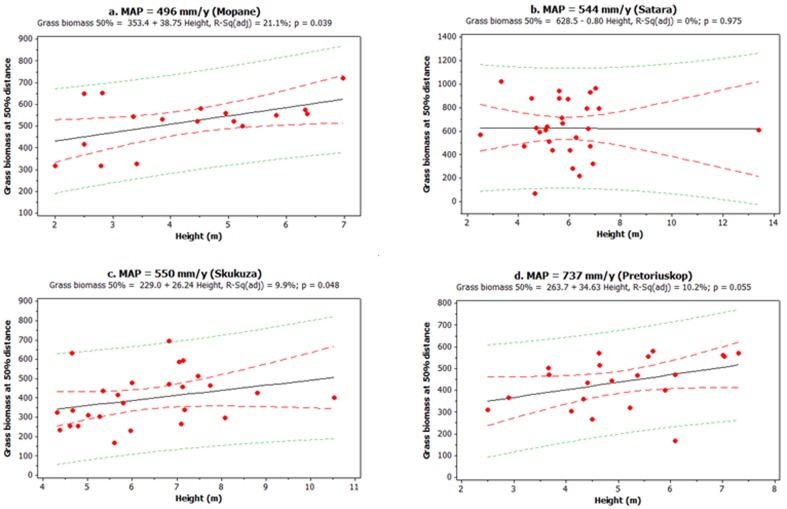
Sub-canopy grass biomass (g.m−2) as a function of tree height (m) at each of the four study sites.Sites are ordered in terms of increasing rainfall from Mopane (a) to Pretoriuskop (d). Sub-canopy grass biomass refers to grass biomass measured at 50% of the canopy radius, i.e. half way between the base of the tree and canopy edge. Solid lines are the best fit regression, dashed lines the 95% confidence interval, and the dotted lines the 95% predicted interval. Removal of the tallest tree in Satara as an outlier does not qualitatively change the outcome of the regression.